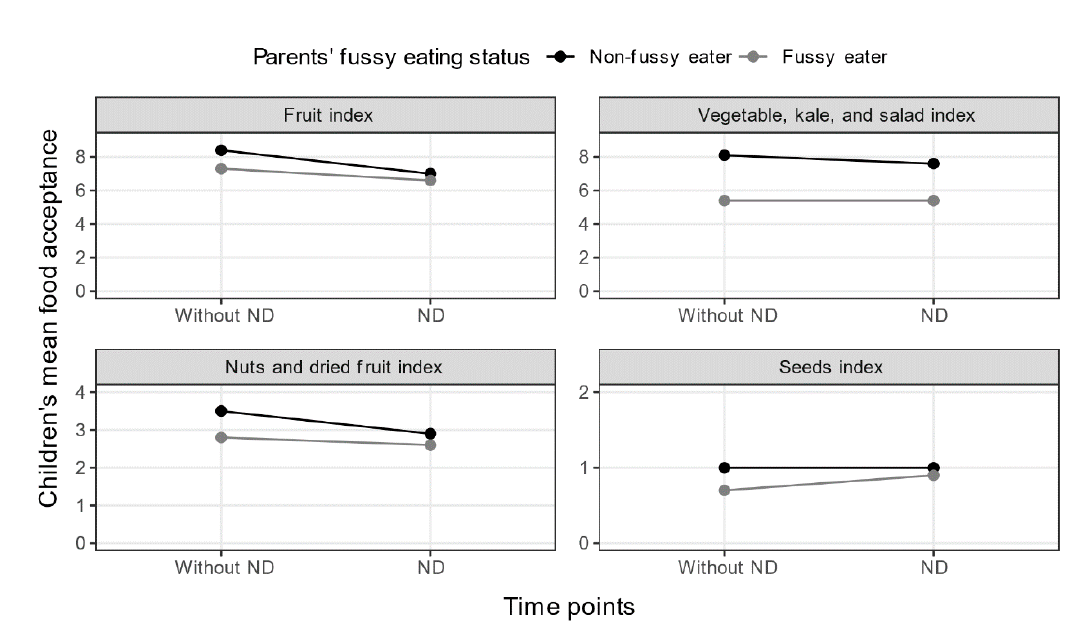
Figure 1. Children’s mean acceptance for various food items based on children’s ND-status and parents’ fussy eating status.